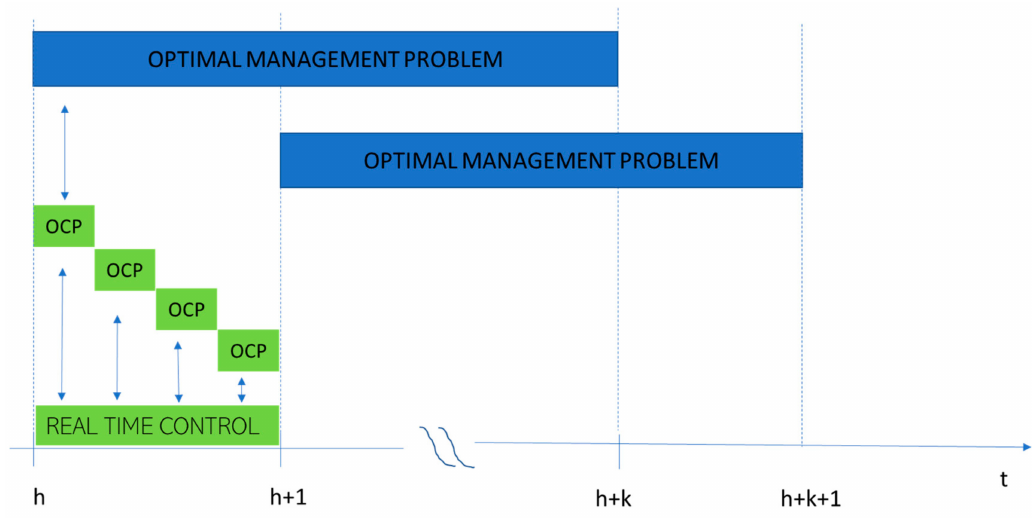
Figure 8. Time sequence of the optimal management problem and of the optimal control problem (OCP).